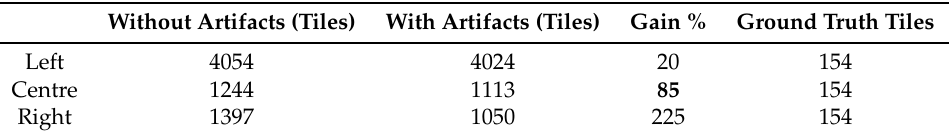
Table 3. CNN gain performance. Metric for Figure